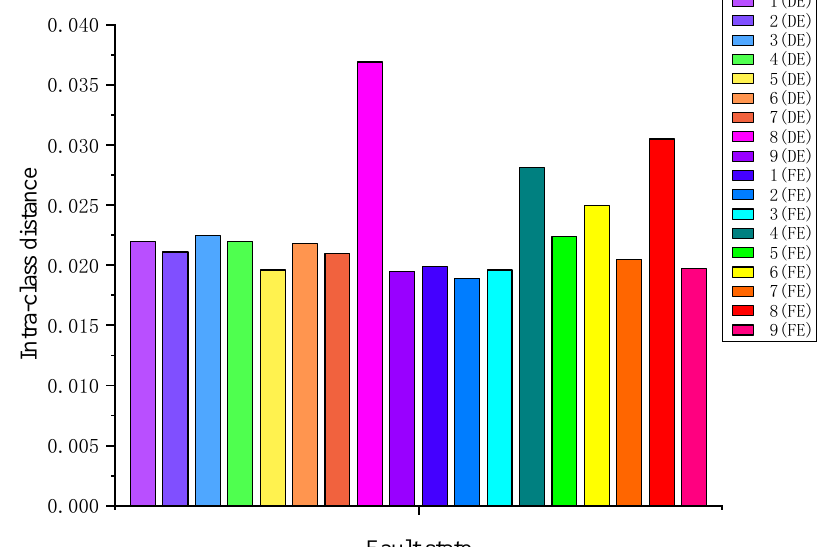
Figure 5. Intra-class distance S w of each fault state.